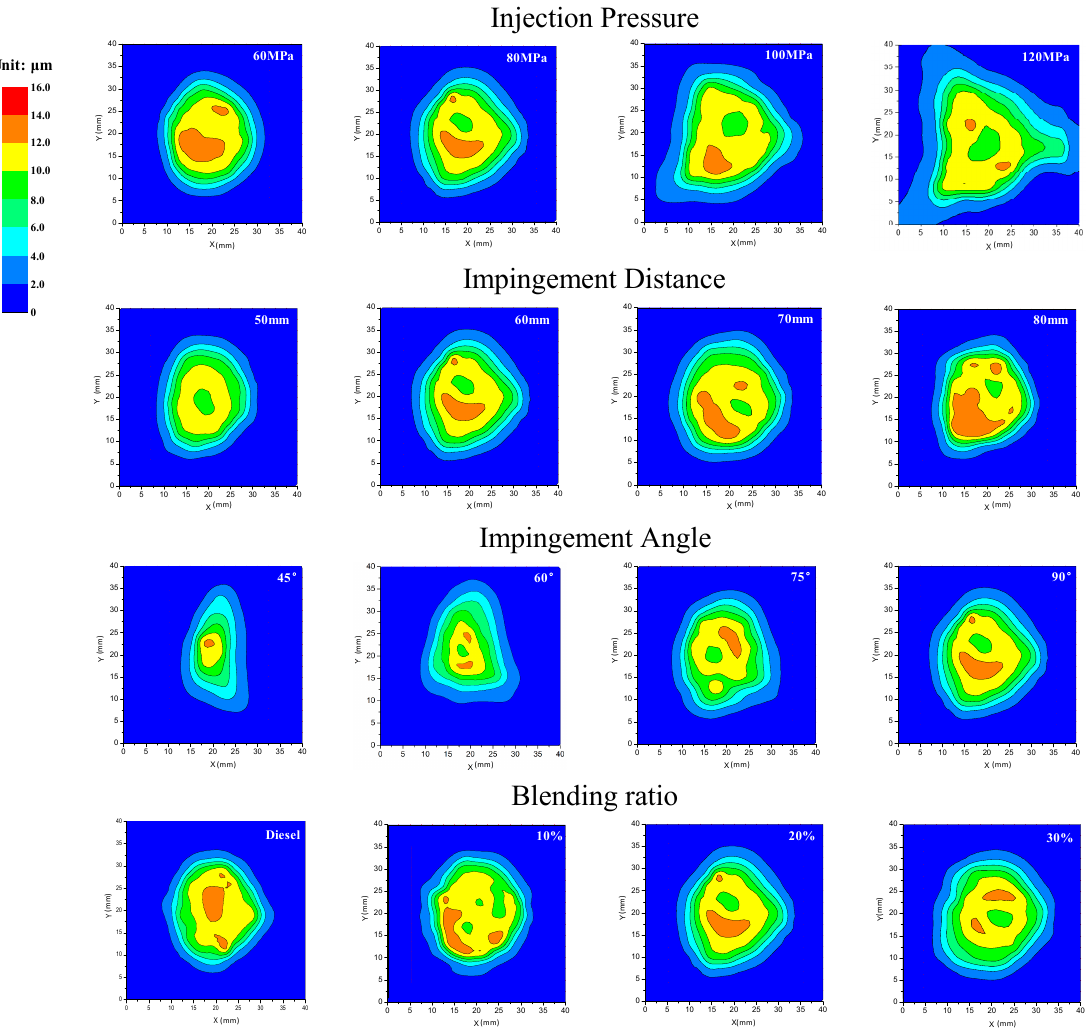
Figure 7. Wall film distributions under dry wall conditions.